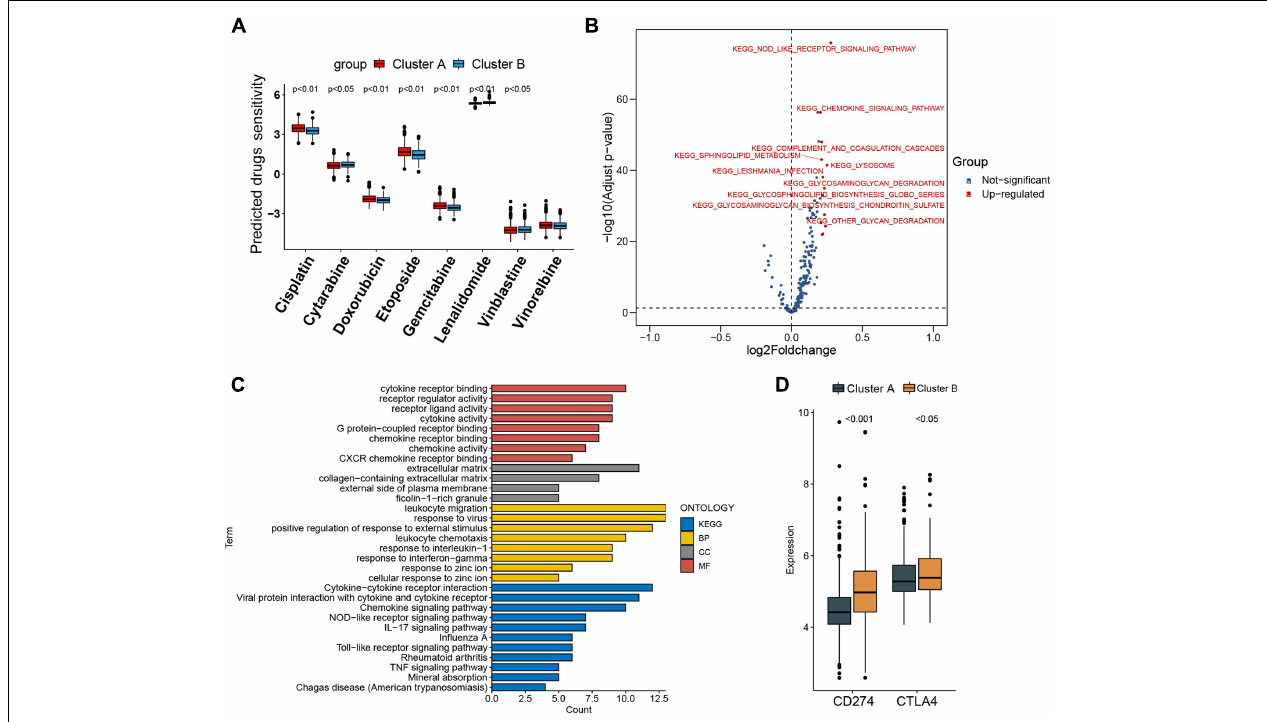
FIGURE 4 | Prediction of chemotherapy and immunomodulatory effect and biological characteristics in distinct subtypes. (A) Sensitivity analysis of eight common therapeutic drugs in patients of cluster A and cluster B. (B) Differences in pathway activities scored by gene set variation analysis between cluster A and cluster B patients. Red dot indicates activated pathways in cluster B patients, and blue dot indicates insignificant activated pathways between cluster A and cluster B patients. (C) Functional annotation and Kyoto Encyclopedia of Genes and Genomes pathway enrichment analysis for differentially expressed genes between cluster A and cluster B patients. BP, biological process; CC, cellular component; MF, molecular function. (D) CD274 (PD-L1) and CTLA4 expression difference in cluster A and cluster B.